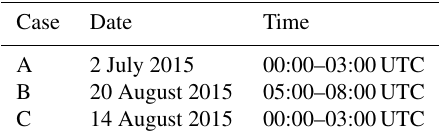
Table 2. The three validation